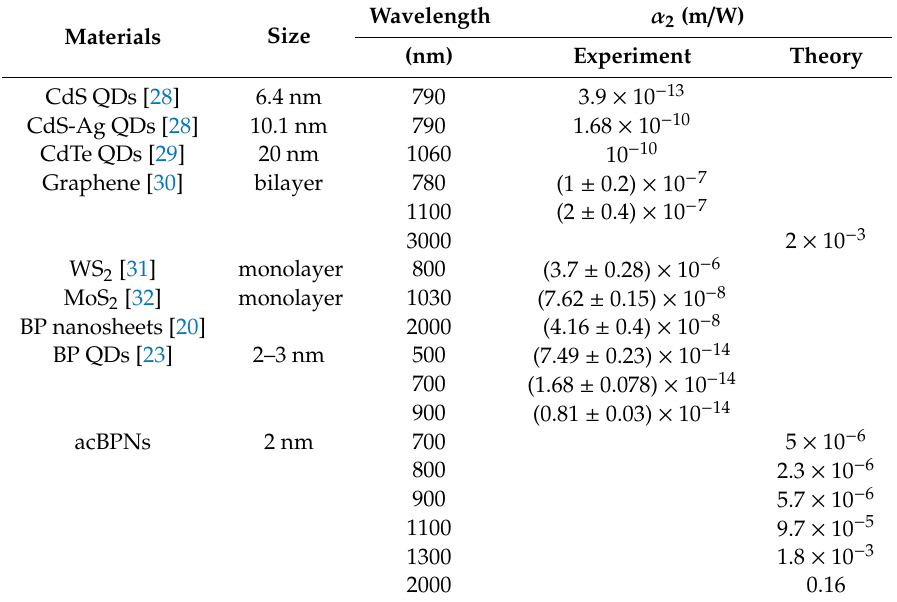
Figure 3. ( a ) Absorption spectra for monolayer acBPNs with three different widths only result from intra conduction band transitions. ( b )Two-photon absorption spectra of monolayer acBPNs for inter band transitions. ( c ) The peak value of absorption coefficient as a function of the atom numbers in unit cell for acBPNs. Table 1. Calculated and experimental two-photon absorption coefficients for acBPNs and other related materials.